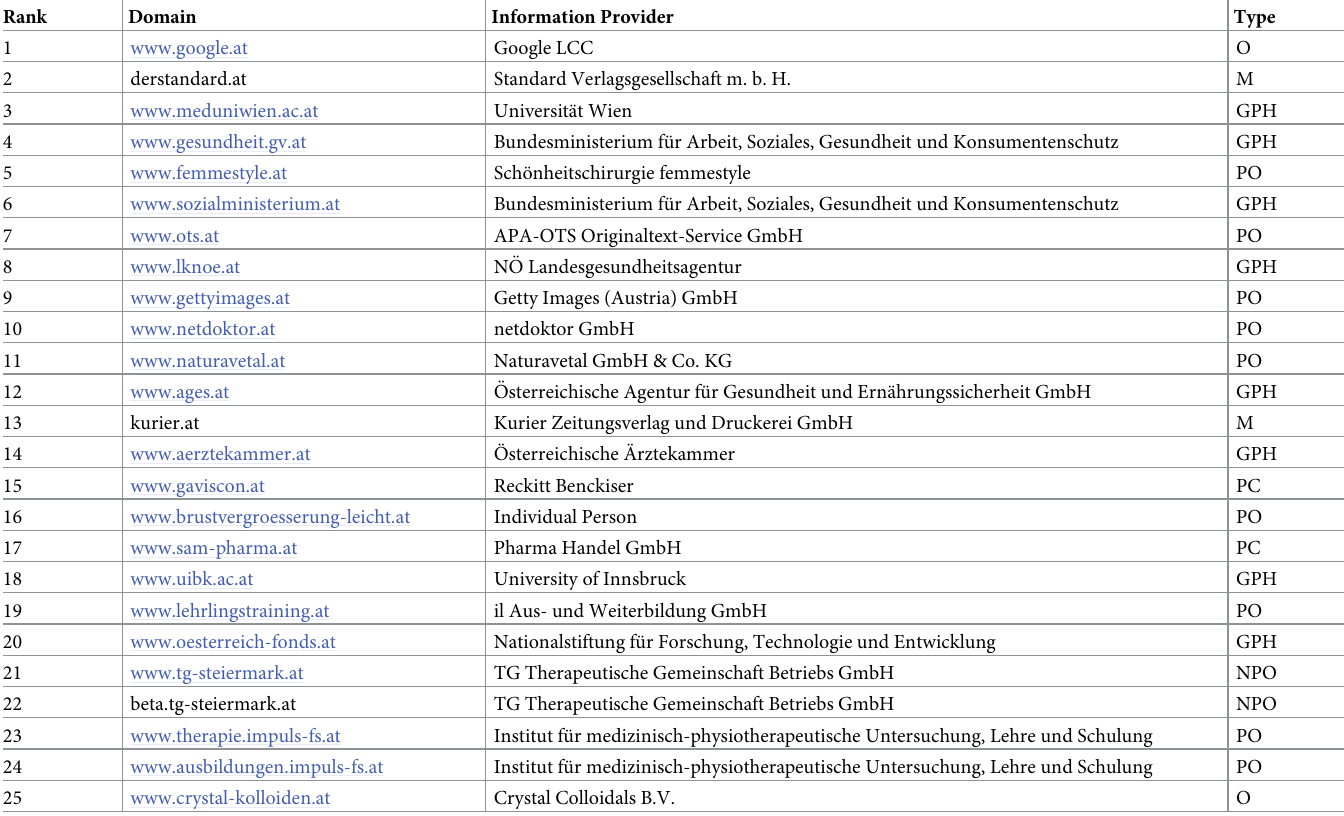
Table 2. Domains of 25 top-ranked web sites for ccTLD “.at” with their respective information provider according to